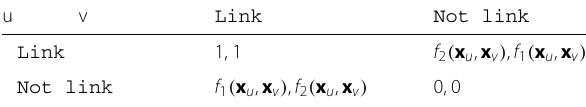
Table 1 The utility table of the game for noiseless